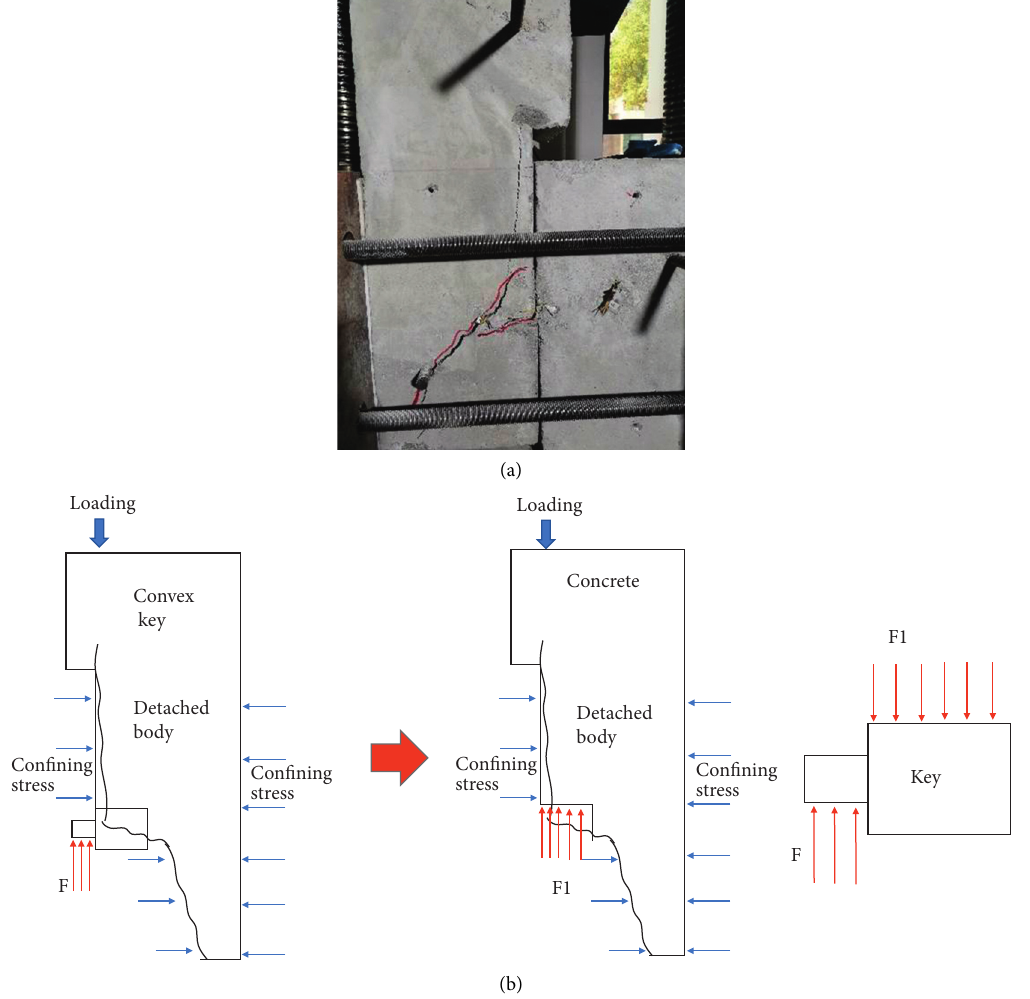
Figure 10: Failure state. (a) Failure mode and (b) mechanical diagram after specimen failure.